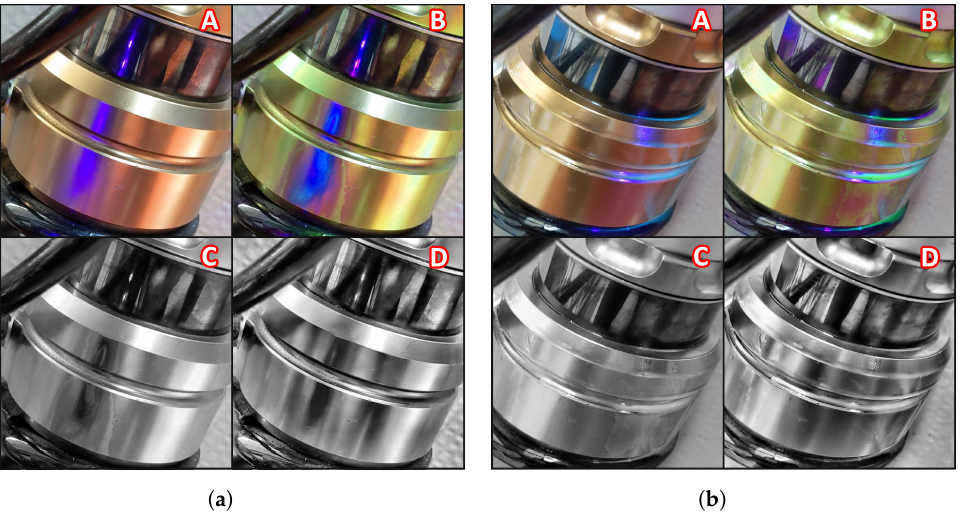
Figure 2. ( a ) Normally functioning AirTender processed in four different ways: original image (A), CLAHE filter (B), gray + CLAHE (C) and CLAHE + gray (D). ( b ) Faulty AirTender: original image (A), CLAHE filter (B), gray + CLAHE (C) and CLAHE + gray (D). Oil fluorescence is clearly visible on the core of